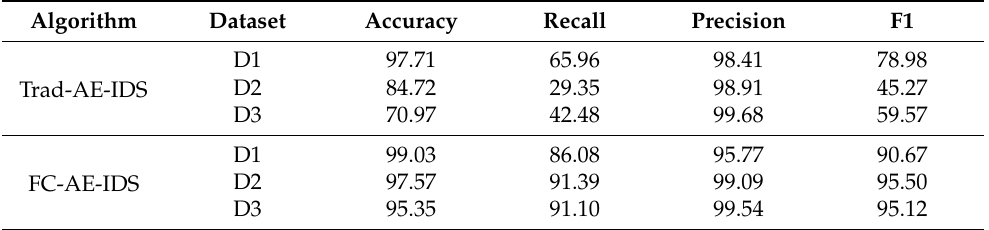
Table 4. Comparison of performance between different algorithms for different datasets.